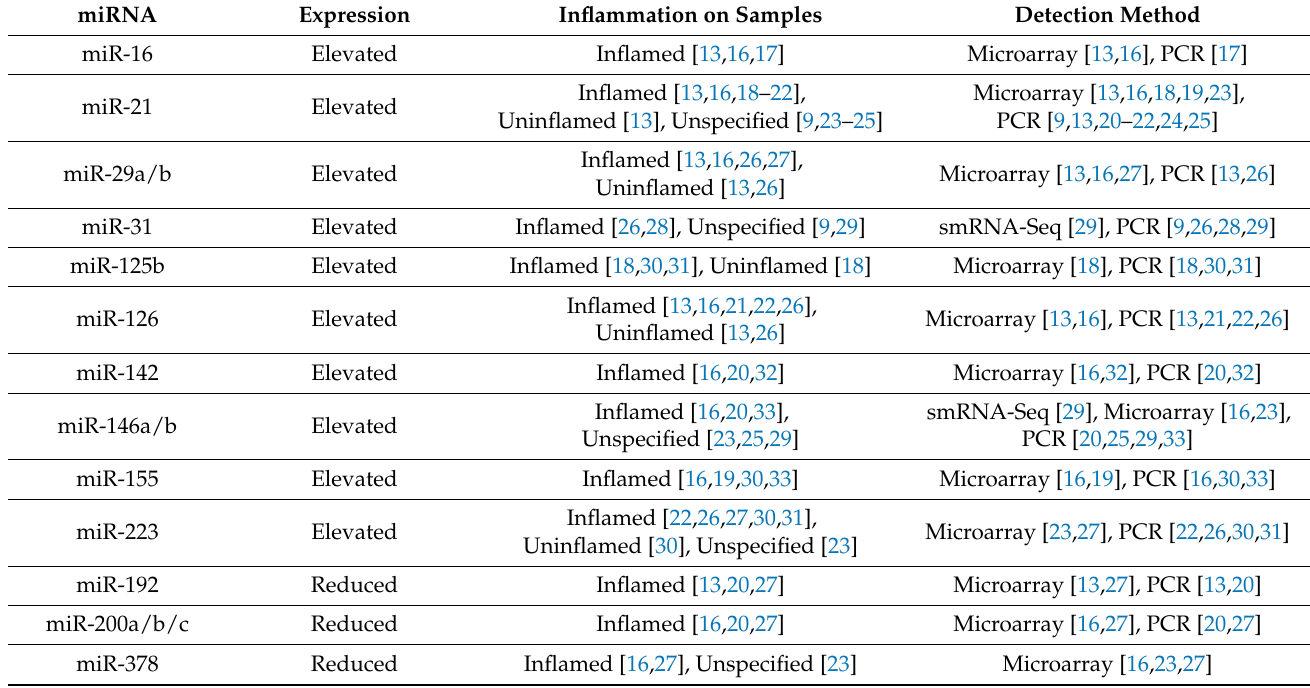
Table 1. miRNAs with altered expression in colonic mucosa of patients with UC compared to healthy individuals. miRNA Expression Inflammation on Samples Detection Method miR-16